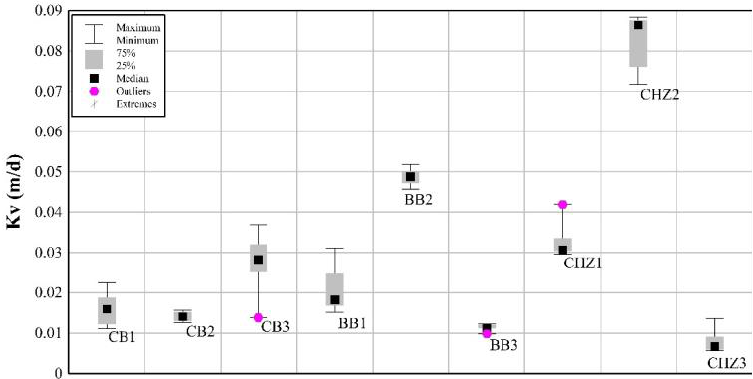
Figure 7. Hydraulic conductivity values, Kv , (m / day) in box-and-whisker graph (bottom).